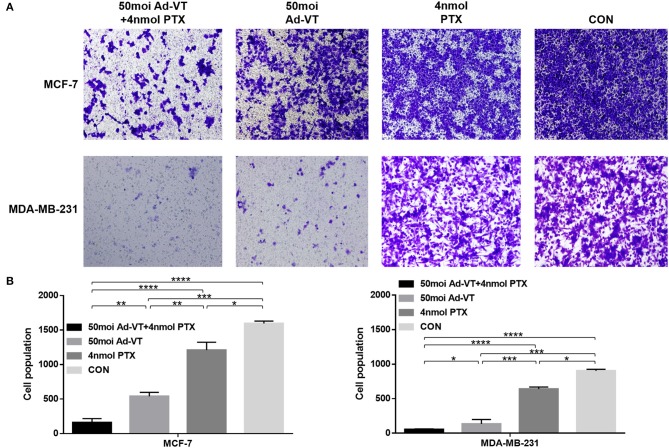
Effects on MCF-7 and MDA-MB-231 cells migration assessed using the Transwell assay. (A) Suppression of MCF-7 and MDA-MB-231 cells migration 72 h after treatment with Ad-VT, paclitaxel, and Ad-VT and paclitaxel mixture. (B) Cells that had migrated through the membrane were counted under a microscope after fixation with carbinol and staining with crystal violet. Cells infected with the combination Ad-VT and paclitaxel showed the lowest migration at 72 h. All measurements were performed in triplicate. *p < 0.05, **p < 0.01, ***p < 0.001, ****p < 0.0001.